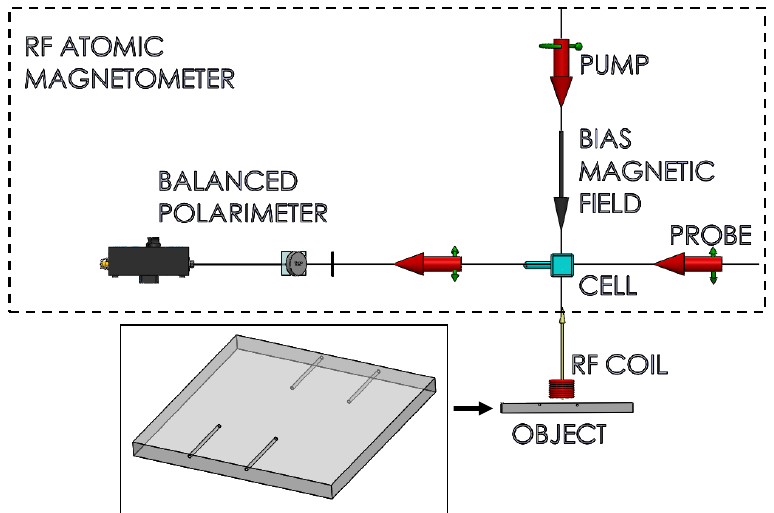
Figure 1. (colour online) Magnetic induction tomography with a radio-frequency atomic magnetometer. An rf coil produces the rf primary field that excites the object response (secondary field). The area enclosed by the dashed box shows the components that make up the rf atomic magnetometer and solid box details the geometry of the holes in the object used for the validation of concealed defect